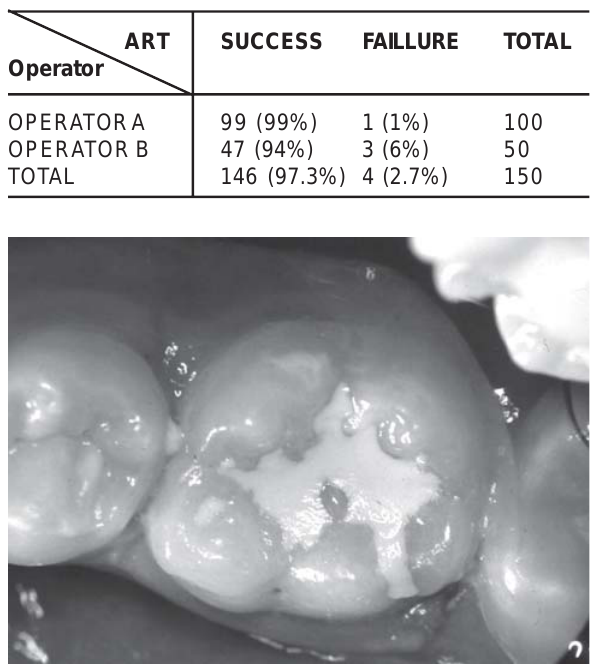
TABLE 2- Success rate of 150 ART restorations after 6months, according to operator